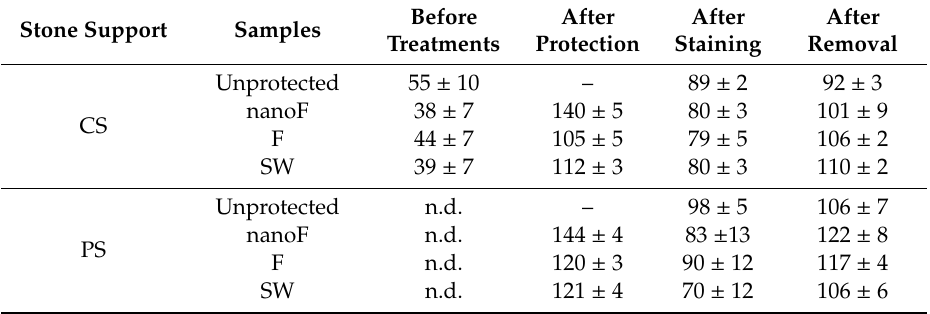
Table 6. Water-stone contact angles (in degrees) before and after the protective treatments, after the staining by felt-tip marker, and after the cleaning. For each data set the standard deviation is reported. Stone Support